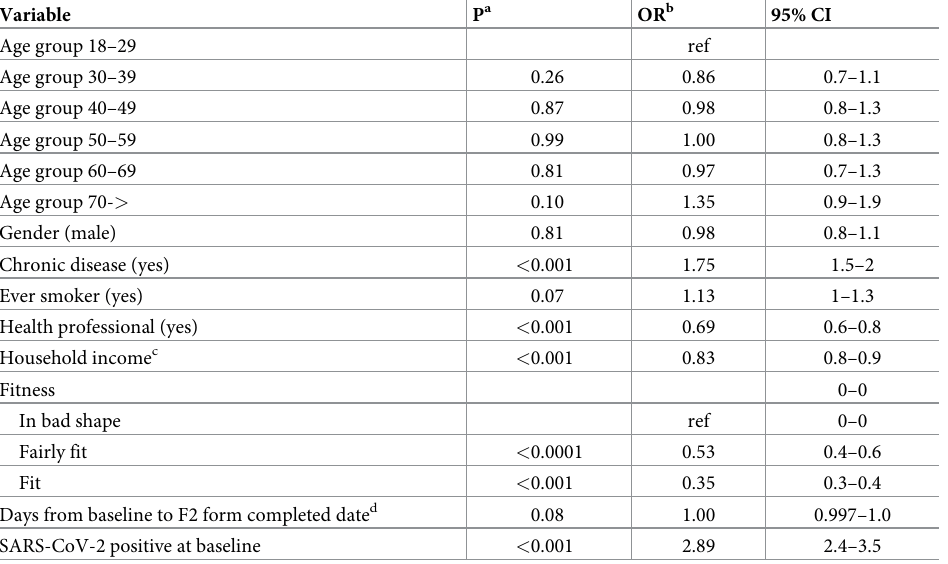
a p-value for the fully adjusted logistic regression model.